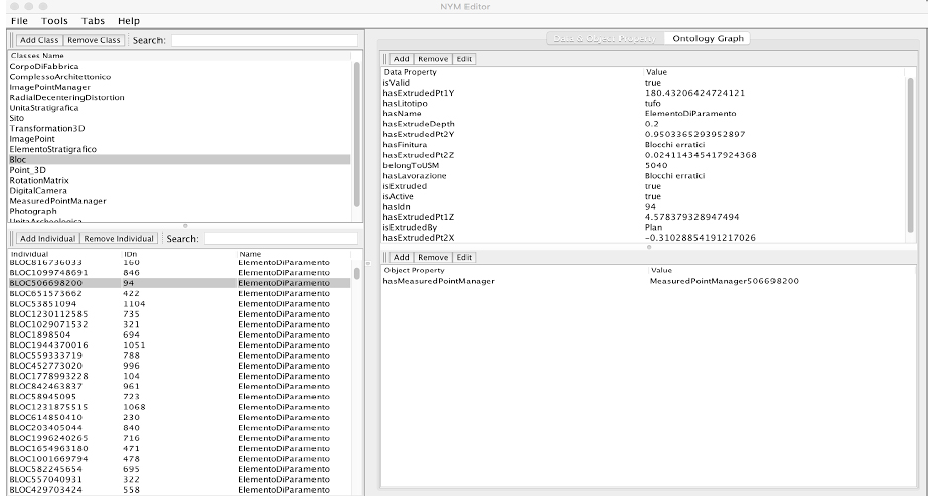
Figure 11. The ontology editor: classes, instances and properties edition from the OWL